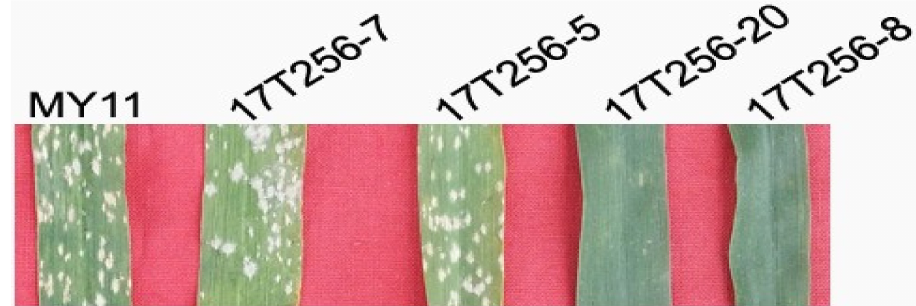
Figure 6. Identification of resistance to powdery mildew. Parental wheat and lines without 6D/6RL Ku translocation chromosomes and lines with only one 6DS/6RL Kumi200 chromosome are highly susceptible to powdery mildew. Lines with one 6DS/6RL Kumi200 and one 6DL/6RL Kumi119 chromosome and lines with only one 6DL/6RL Kumi119 chromosome are highly resistant to powdery